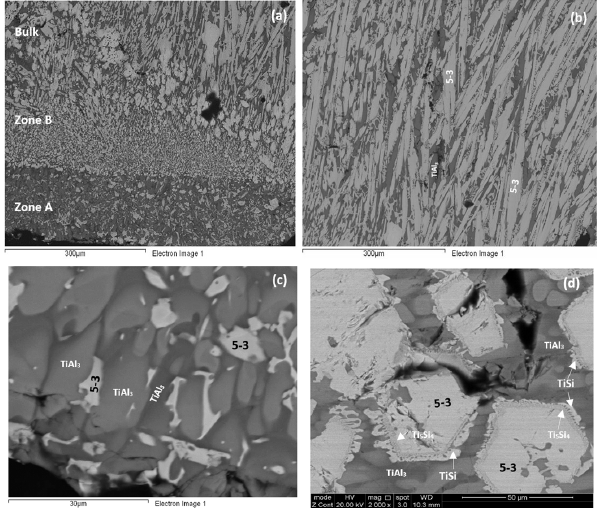
Figure 4. SEM backscatter electron images of the cast alloy Nb 1.3 Si 2.4 Ti 2.4 Al 3.5 Hf 0.4 . ( a , b ) low magnification images ( a ) showing zones A, B and transition to bulk microstructure; ( b ) bulk microstructure; ( c , d ) higher magnification images showing ( c ) details of microstructure in Zone A and ( d ) bulk microstructure.